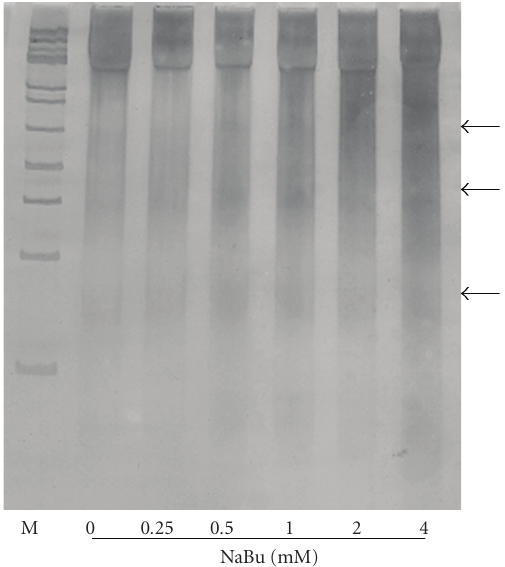
Figure 2: Electrophoretic patterns of DNA isolated from NaBu- treated and untreated CHO cells. Isolated chromosomal DNA (2 μ g) was electrophoresed on 5% polyacrylamide gel and intact and fragmented DNA bands were revealed by silver staining. Arrowheads designate DNA ladder formation. M: molecular weight marker, 100-bp DNA ladder. DNAs were isolated from day 8 cultures exposed to di ff erent concentrations of